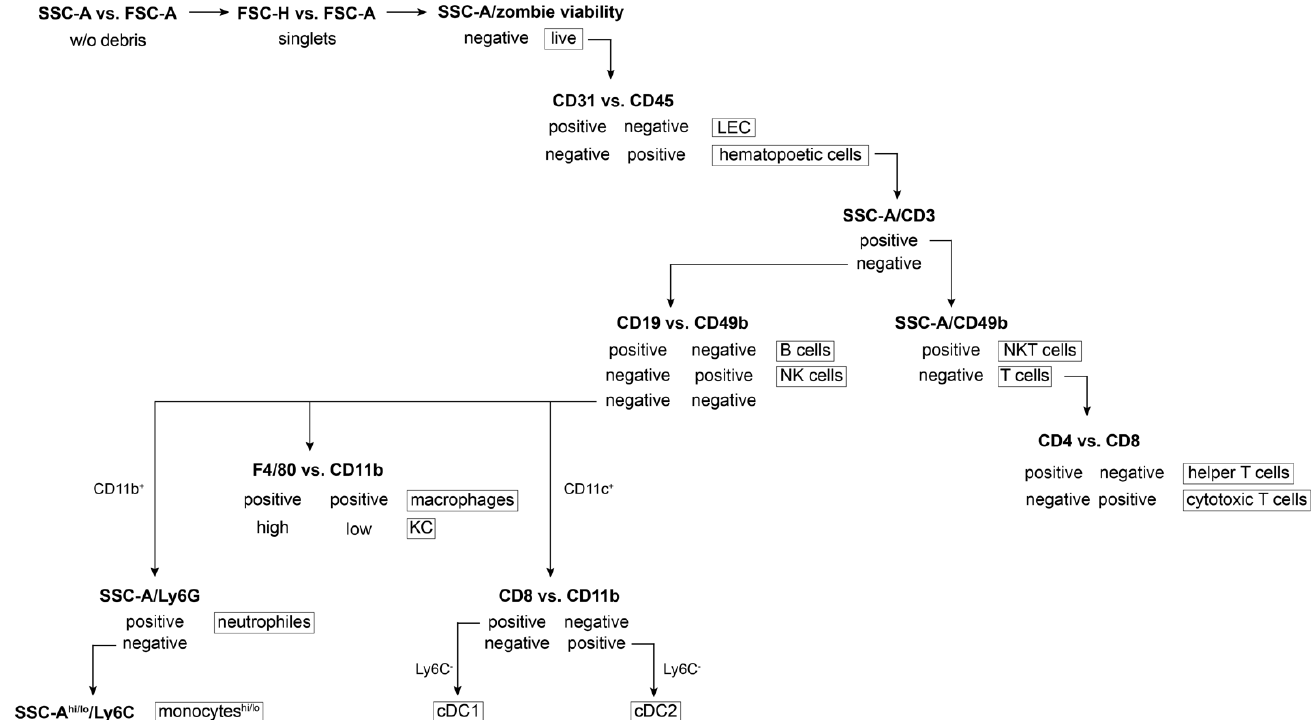
Figure 3. Schema of gating strategy for flow cytometry data acquisition. SSC-A: side scatter – area; FSC-A/H: forward scatter – area/height; hi/lo: high/low population.